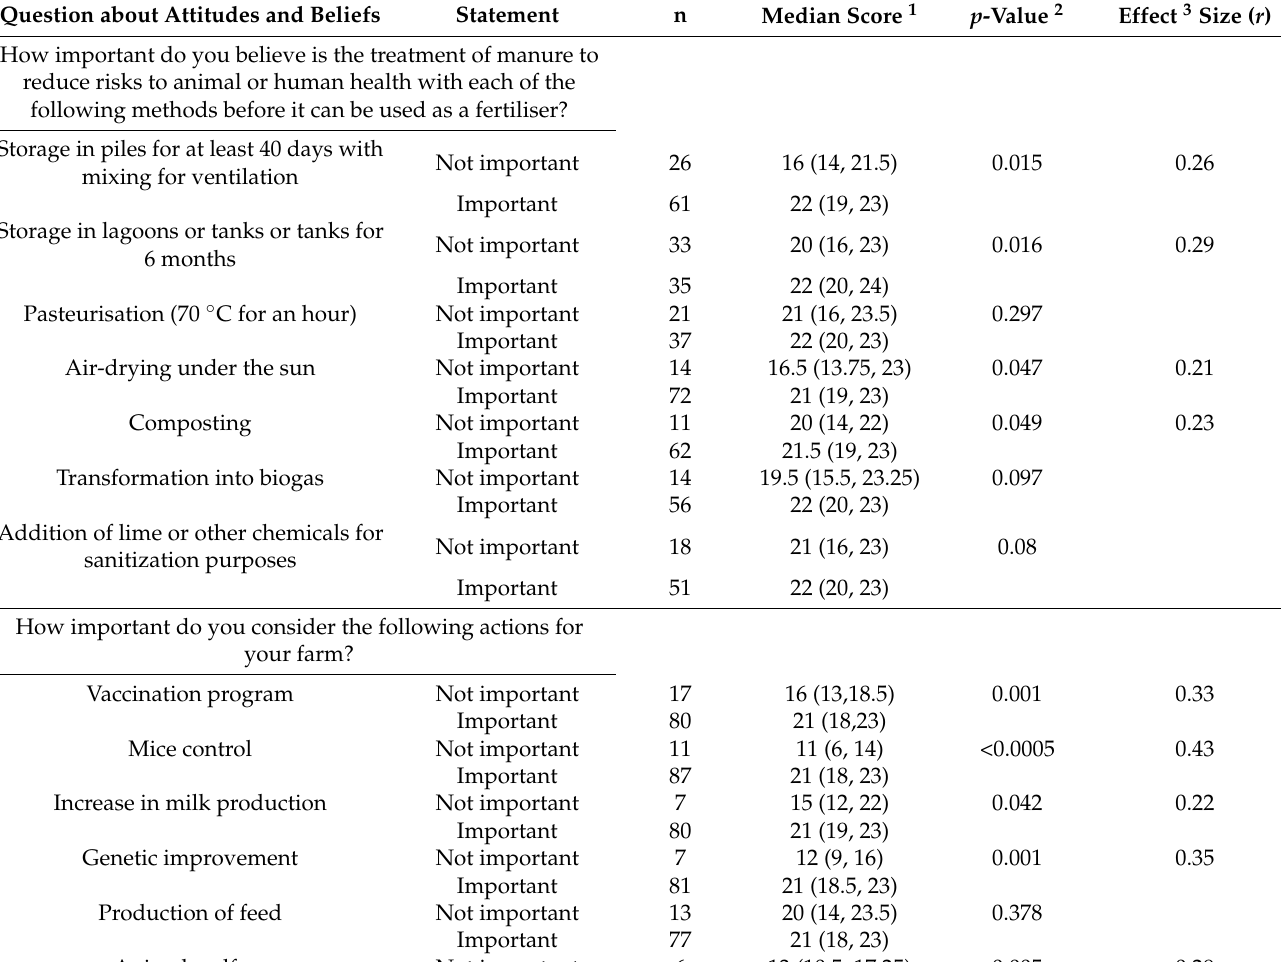
Table 5. Comparison of knowledge scores of farmers with different attitudes and beliefs regarding safe manure management and farming